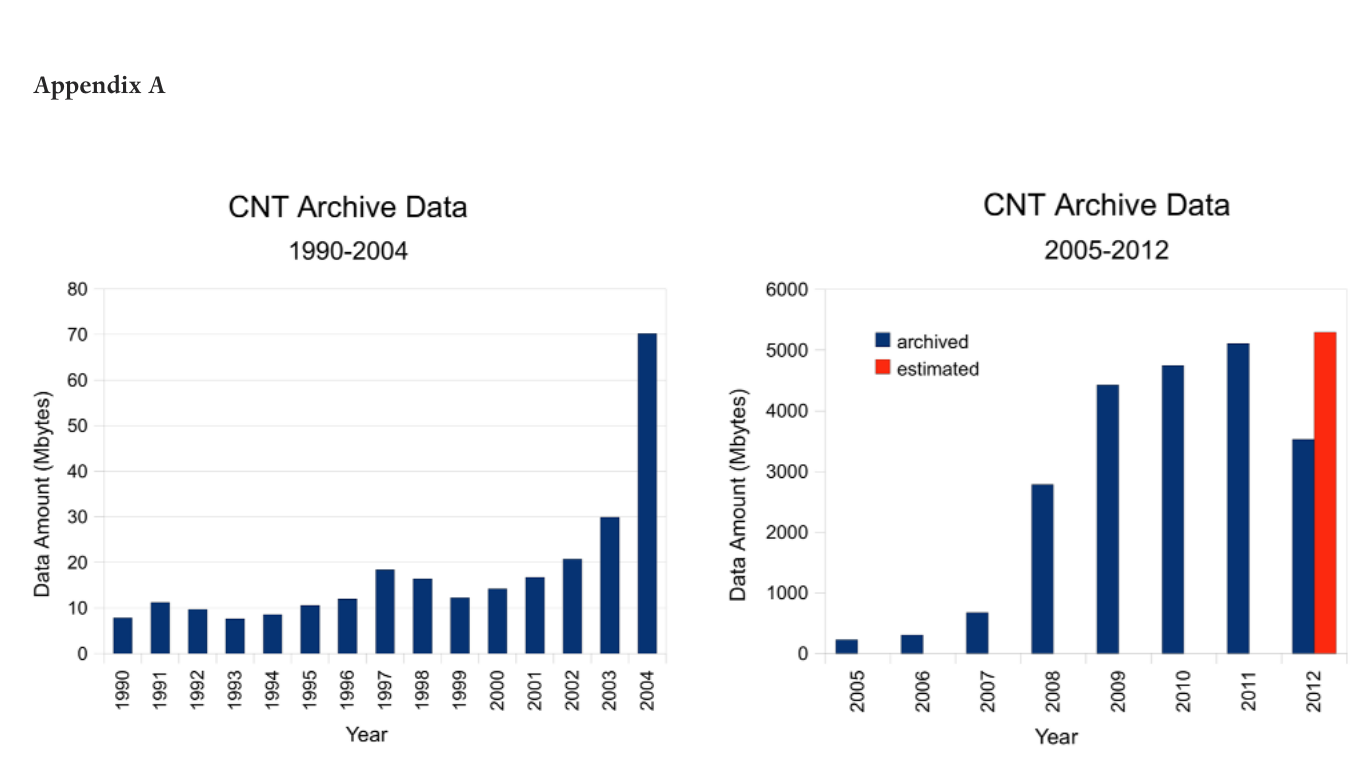
Figure A1. Amount of data archived in the CNT, INGV, database since 1990 (MedNet) to the present (MedNet + INGV National Network + other col- laborating networks).